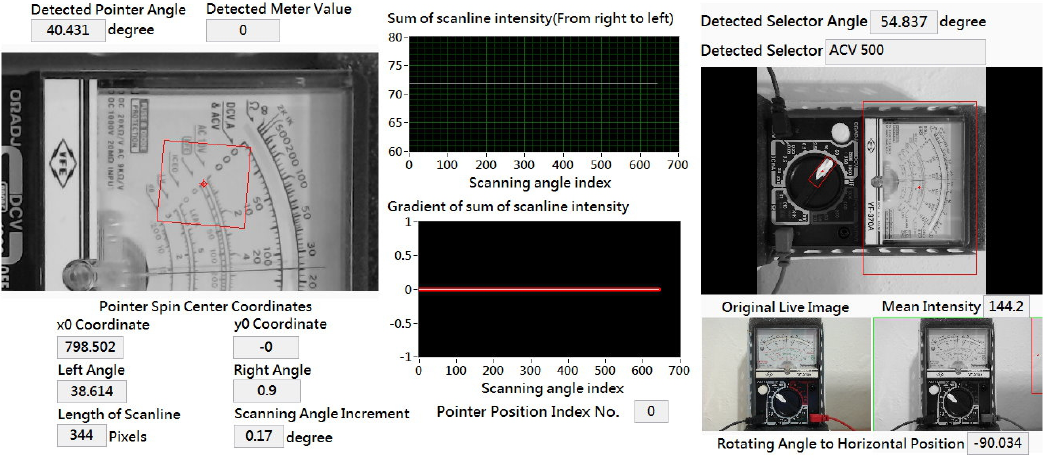
Figure 22. Reading the A-meter fails for the camera placed at I as indicated in Figure